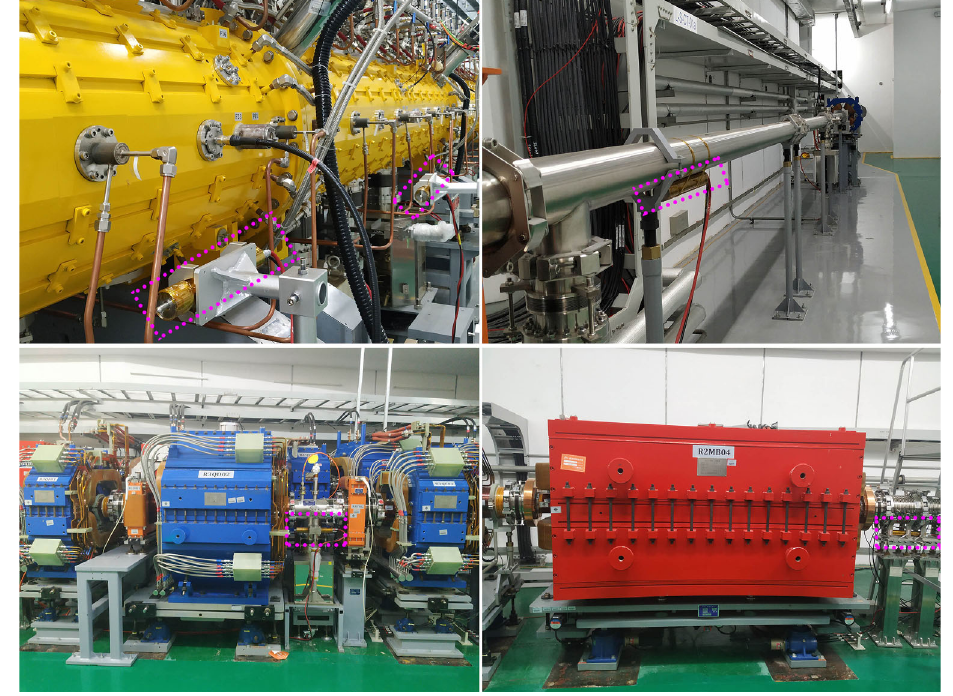
FIG. 3. Several BLMs installed along the CSNS beam line.